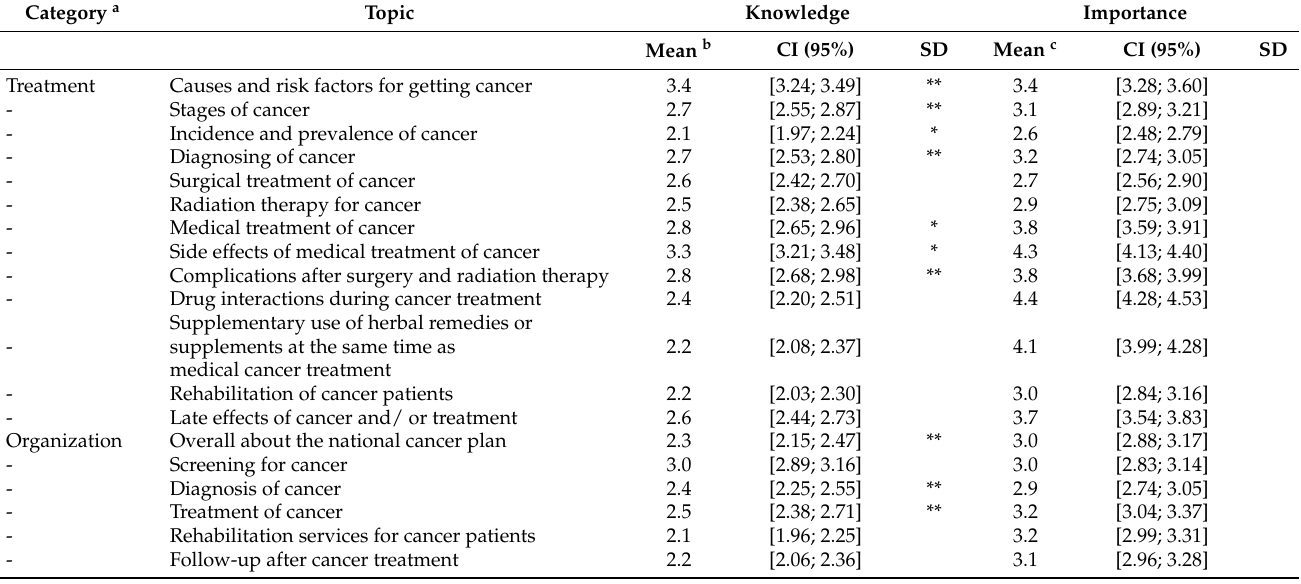
Table 4. Self-perceived level of knowledge and importance of learning more about topics related to the cancer trajectory and cancer treatment, and the organization of cancer care (n =